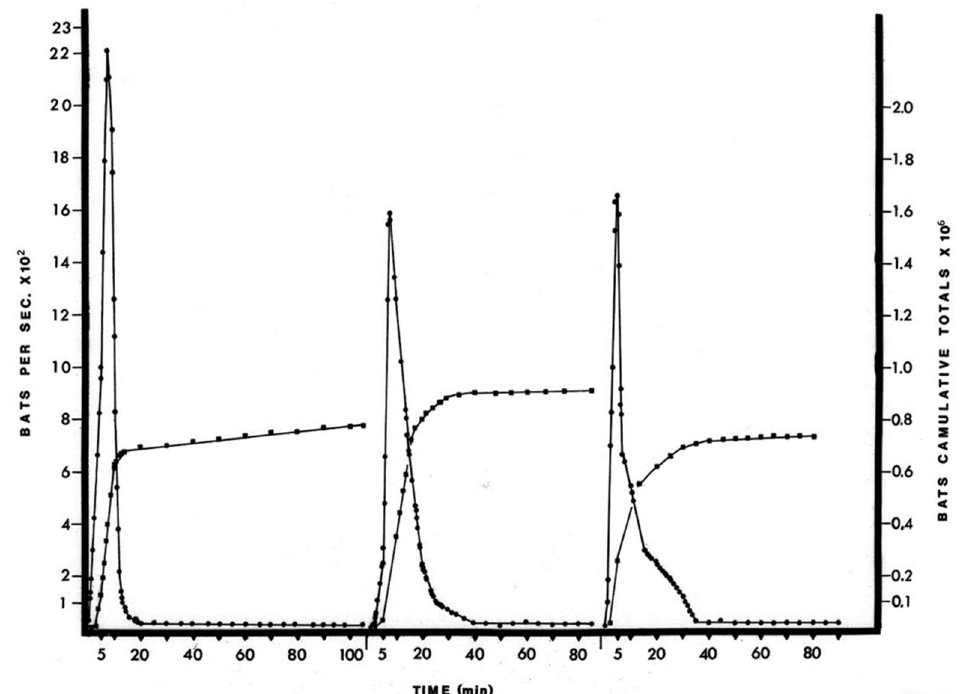
Figure 1. Pattern of wrinkle-lipped free-tailed bat exodus each month from Kaeng Khoi cave during April – June 1973.